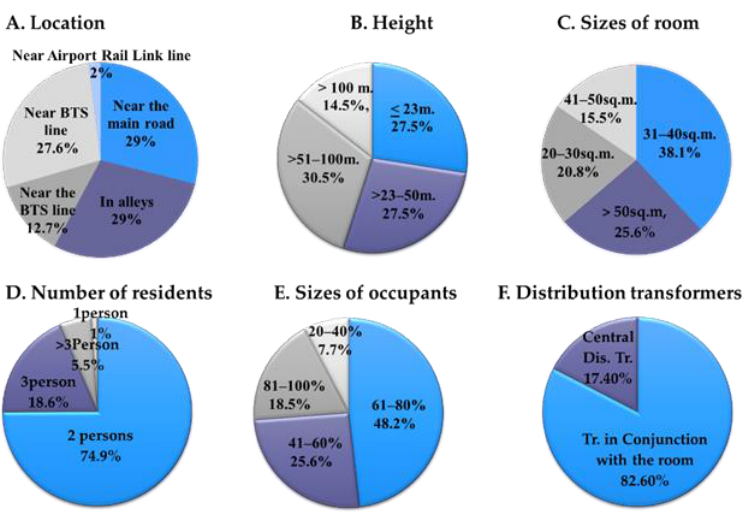
Figure 3. Percentages of locations, heights, sizes of room, number of residents, numbers of occupants, and distribution transformers.